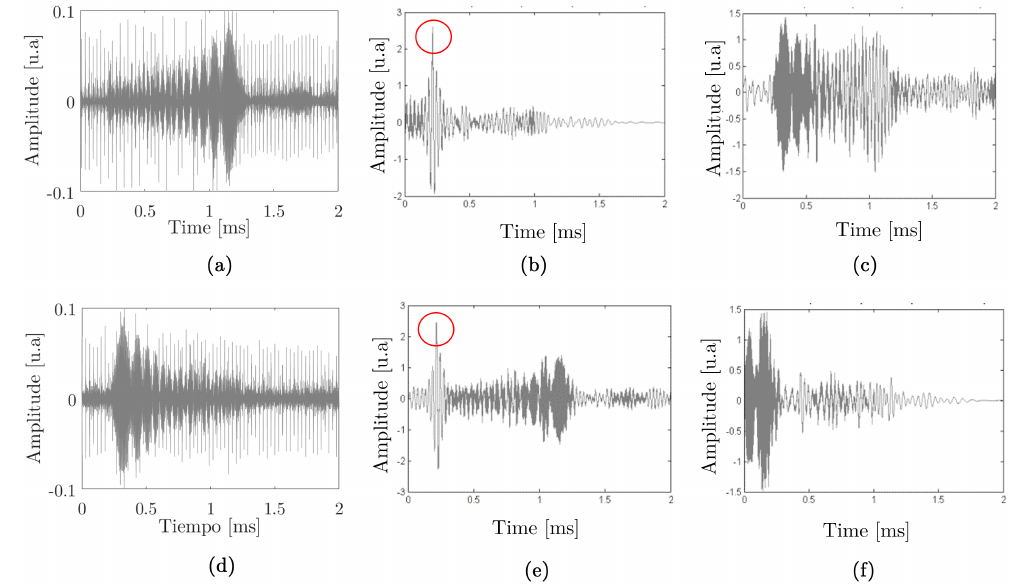
Figure 5. Detection by correlation. ( a ) Bit 1 received; ( b ) correlation of bit 1 received with bit 1 sent; ( c ) correlation of bit 1 received with bit 0 sent; ( d ) bit 0 received; ( e ) correlation of bit 0 received with bit 0 sent; ( f ) correlation of bit 0 received with bit 1